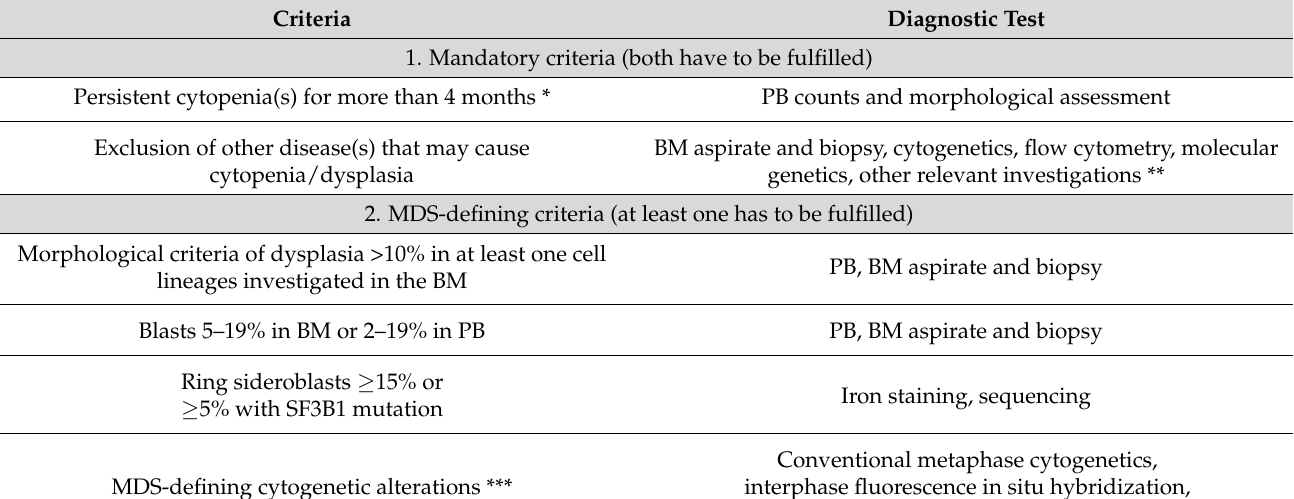
Table 6. Minimal diagnostic criteria for the diagnosis of MDS